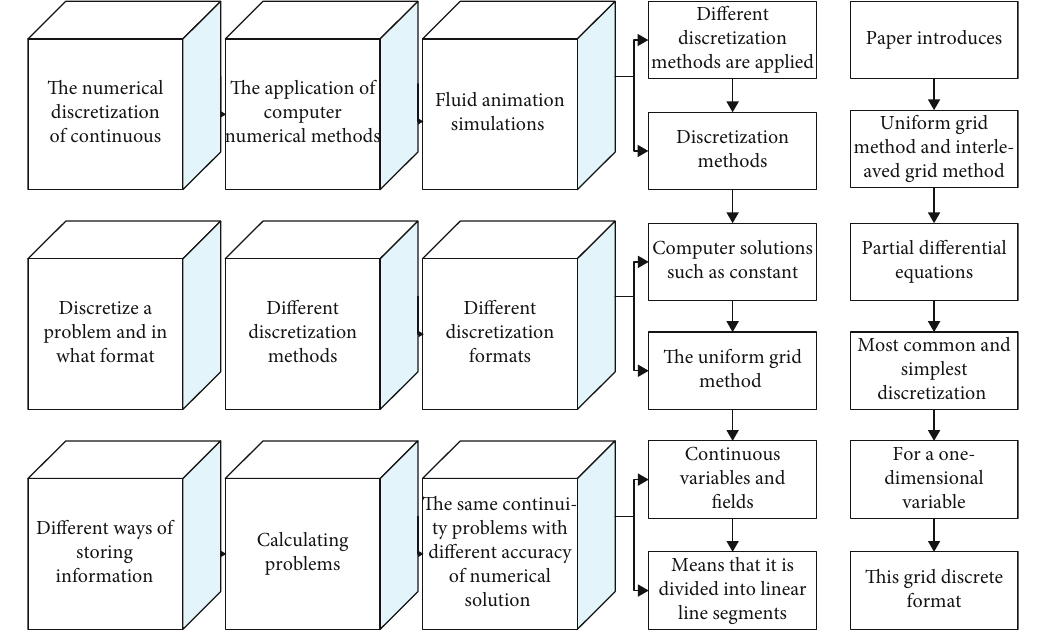
Figure 1: Fluid equation